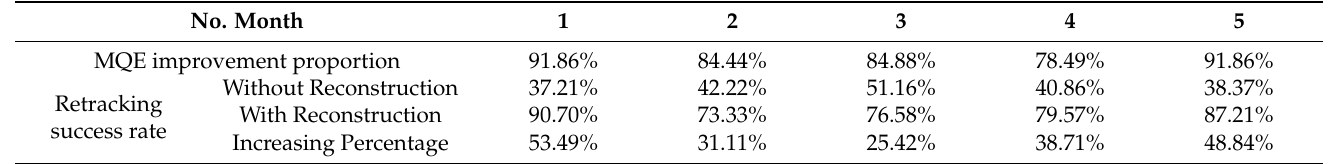
Table 2. MQE improvement proportions and retracking success rates for experimental area